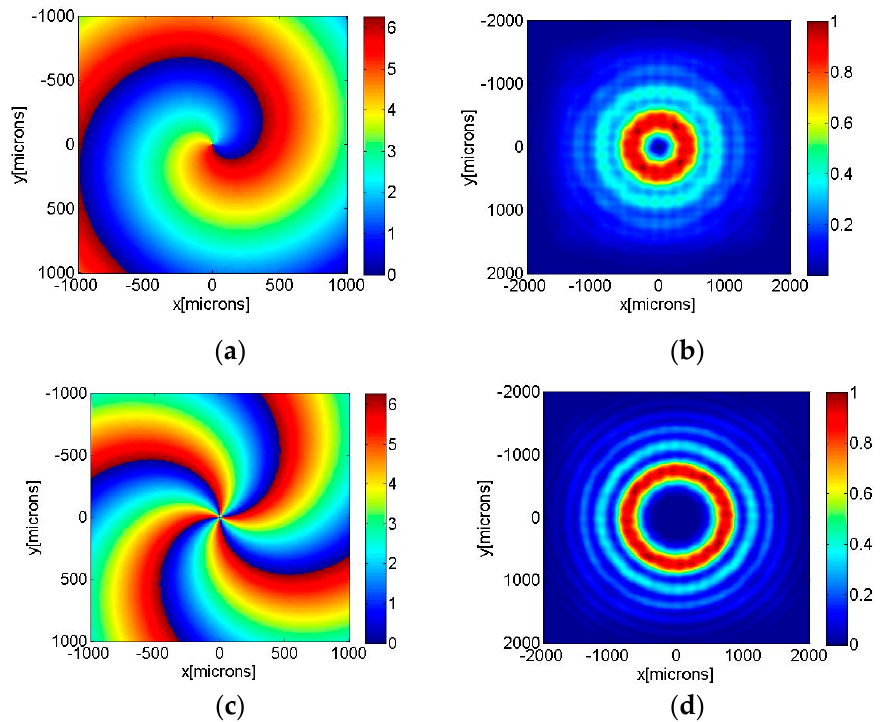
Figure 2. Higher-order axicons with discrete profile (32 levels): ( a ) numerical axicon of first order, m = 1, ( b ) intensity distribution of a Bessel–Gauss beam of order m = 1 generated after the diffraction of a Gaussian beam on the spiral axicon for z = 75 cm, ( c ) numerical axicon of order m = 4, ( d ) intensity distribution of a Bessel–Gauss beam of order m = 4 generated after the diffraction of a Gaussian beam on the spiral axicon for z = 75 cm.